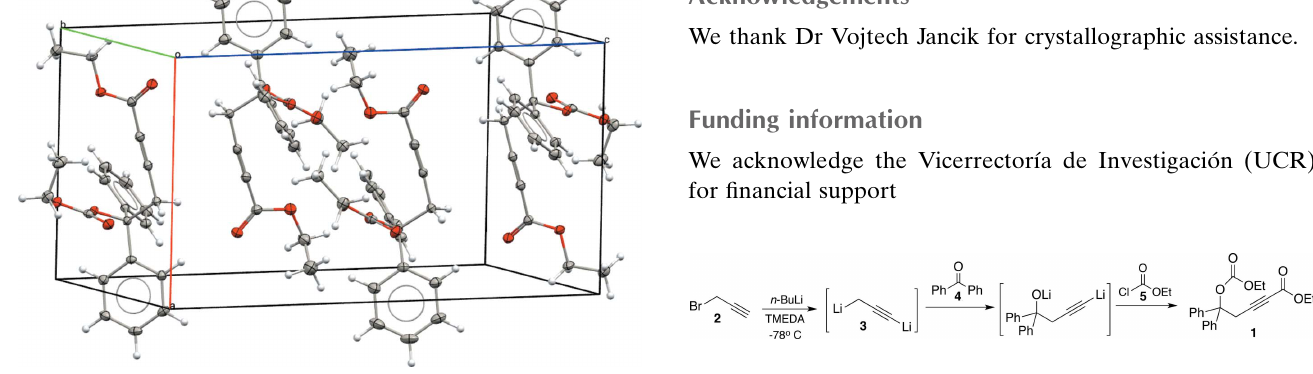
Figure 2 The crystal packing of the title compound.